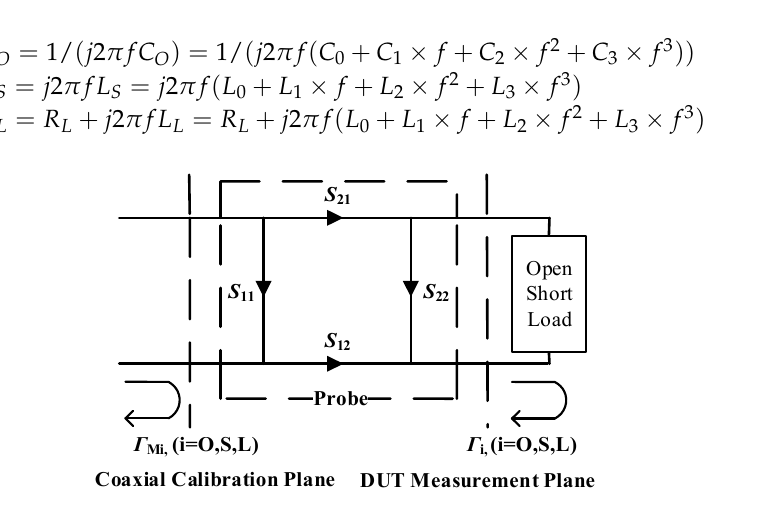
Figure 7. Signal flow chart of the OSL method.